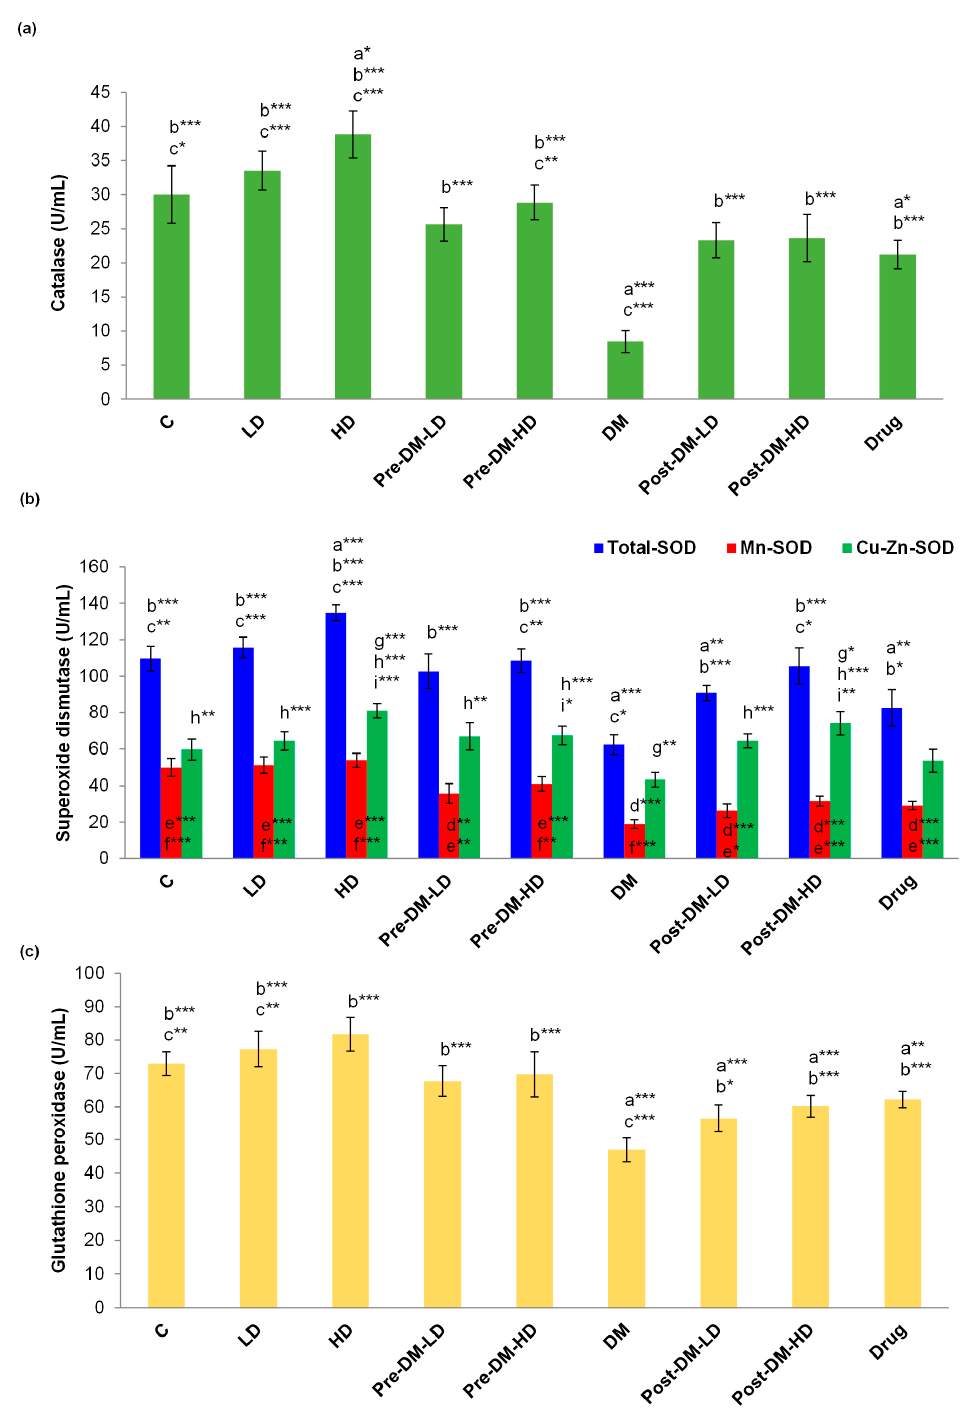
Figure 3. Effect of GBRE supplement on the antioxidant enzymes in the experimental rats. ( a ) Catalase; ( b ) Superoxide dismutase; ( c ) Glutathione peroxidase. C: Control, LD: Low dose of GBRE to naïve rat, HD: High dose of GBRE to naïve rat, DM: Diabetes mellitus-induced rat, Pre-DM-LD: Low dose of GBRE to naïve rat and induced DM, Pre-DM-HD: High dose of GBRE to naïve rat and induced DM; Post-DM-LD: Low dose of GBRE to DM rat, Post-DM-HD: High dose of GBRE to DM rat. The significant difference between the groups (a, d, g = when compared with control group; b, e, h = when compared with DM group; c, f, i = when compared with the drug group) were represented as * ( p < 0.05), ** ( p < 0.01), and *** ( p < 0.001).